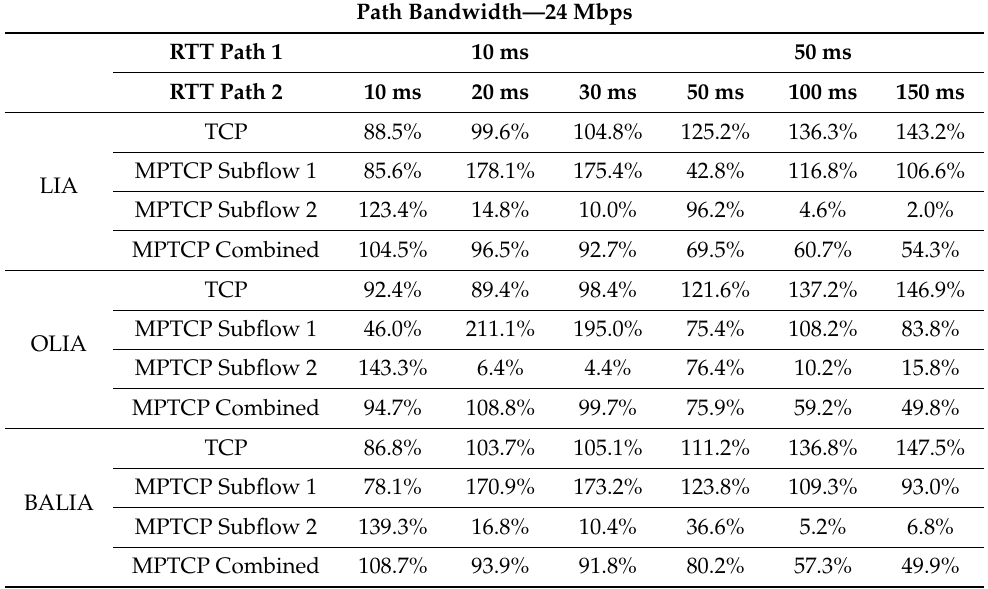
Table 5. Share of 24 Mbps bandwidth attained at Switch One-Shared